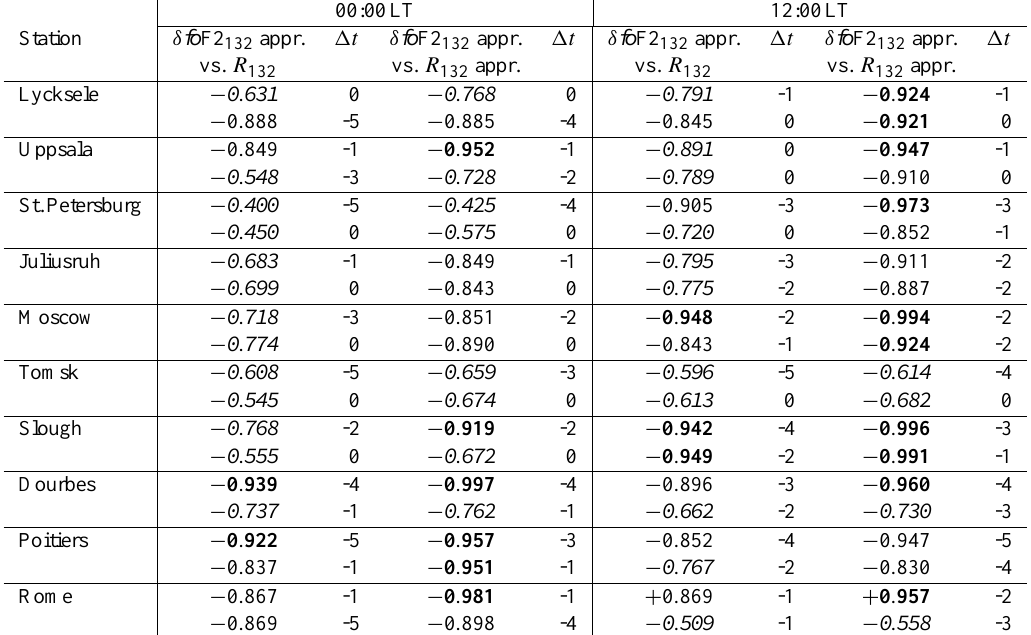
Table 2. Correlation coefficients, r , between δ fo F2 132 and R 132 found over one and the same period 1957–97 (1962–92 after 11-year smoothing). The “appr.” refers to the polynomial approximated δ fo F2 132 and R 132 variations. The first line refers to Q -medians, the second to the usual monthly fo F2 medians used in the calculations. Bold face figures show significant r with a confidence level 99%, normal face figures correspond to 95% confidence level, italic figures are not significant r . The optimal time shift 1t (in years) between δ fo F2 132 and R 132 variations is given as